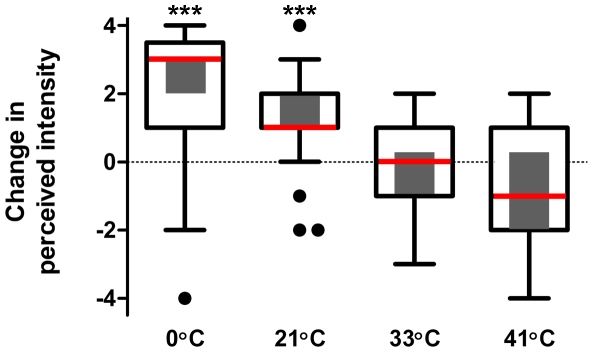
Effect of temperature on the perceived sensation evoked by lingual IBA.Cold (0°C) and cool (21°C) temperatures potentiated the sensation evoked following lingual IBA whereas warm (37°C) and hot (41°C) temperatures had no effect. Box-whisker plots demonstrate the distribution of responses obtained from individuals at each temperature. White boxes on box-whisker plots correspond to the inter-quartile range (25%–75%), vertical lines indicate range of responses, the red horizontal line indicates median values and the black circles indicate outlier responses as determined by Tukey's analysis. The grey bar inside each white box indicates the 95% confidence interval. Confidence intervals not crossing the abscissa indicate that perceived intensity was significantly (p<0.05) different from 0 (no difference between d0 and d1; see Figure S2 for scale) and are denoted by the *** above the appropriate box-whisker plot.